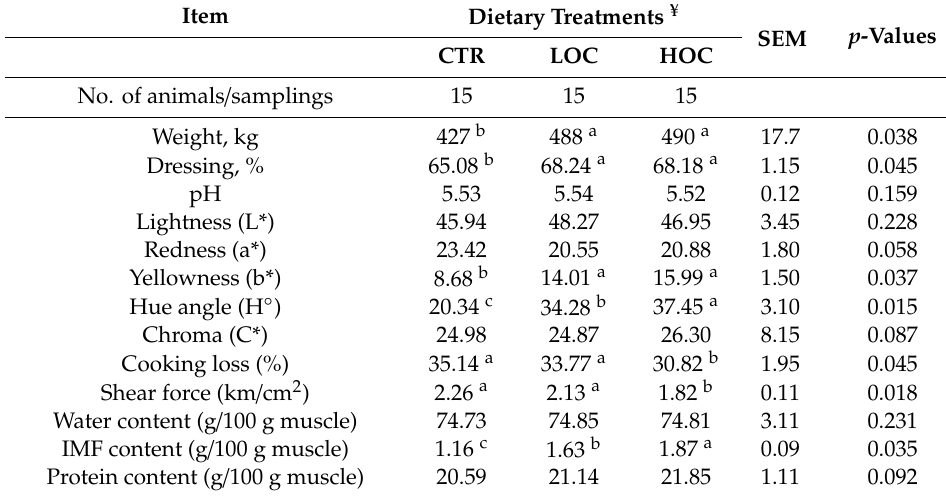
Table 5. E ff ect of dietary olive cake supplementation on carcass traits and physicochemical properties of Longissimus lumborum muscle at 7 days of storage of Limousin young